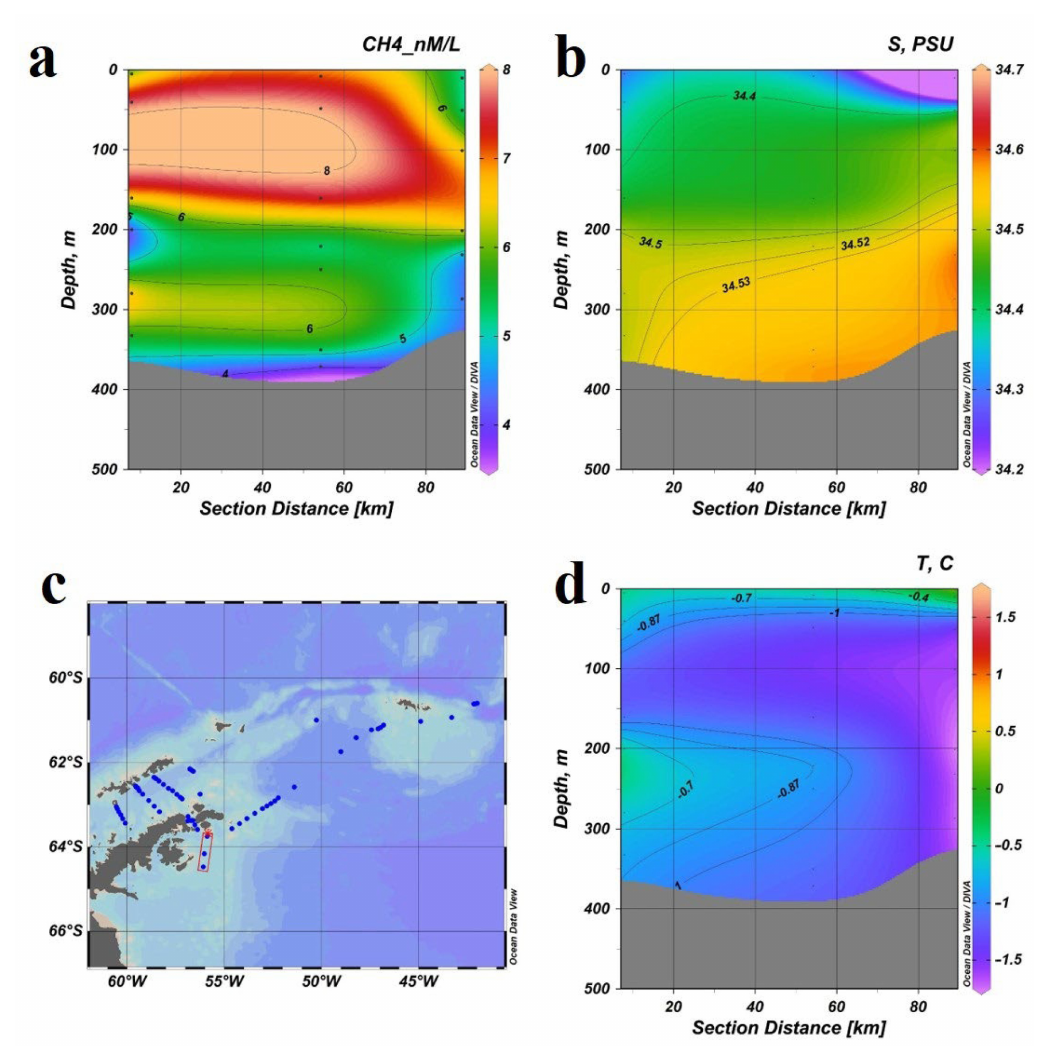
Figure 9. Distribution of methane concentration ( a ), temperature ( d ) and salinity ( b ) on the section ( c ) in the Weddell Sea south of the Antarctic